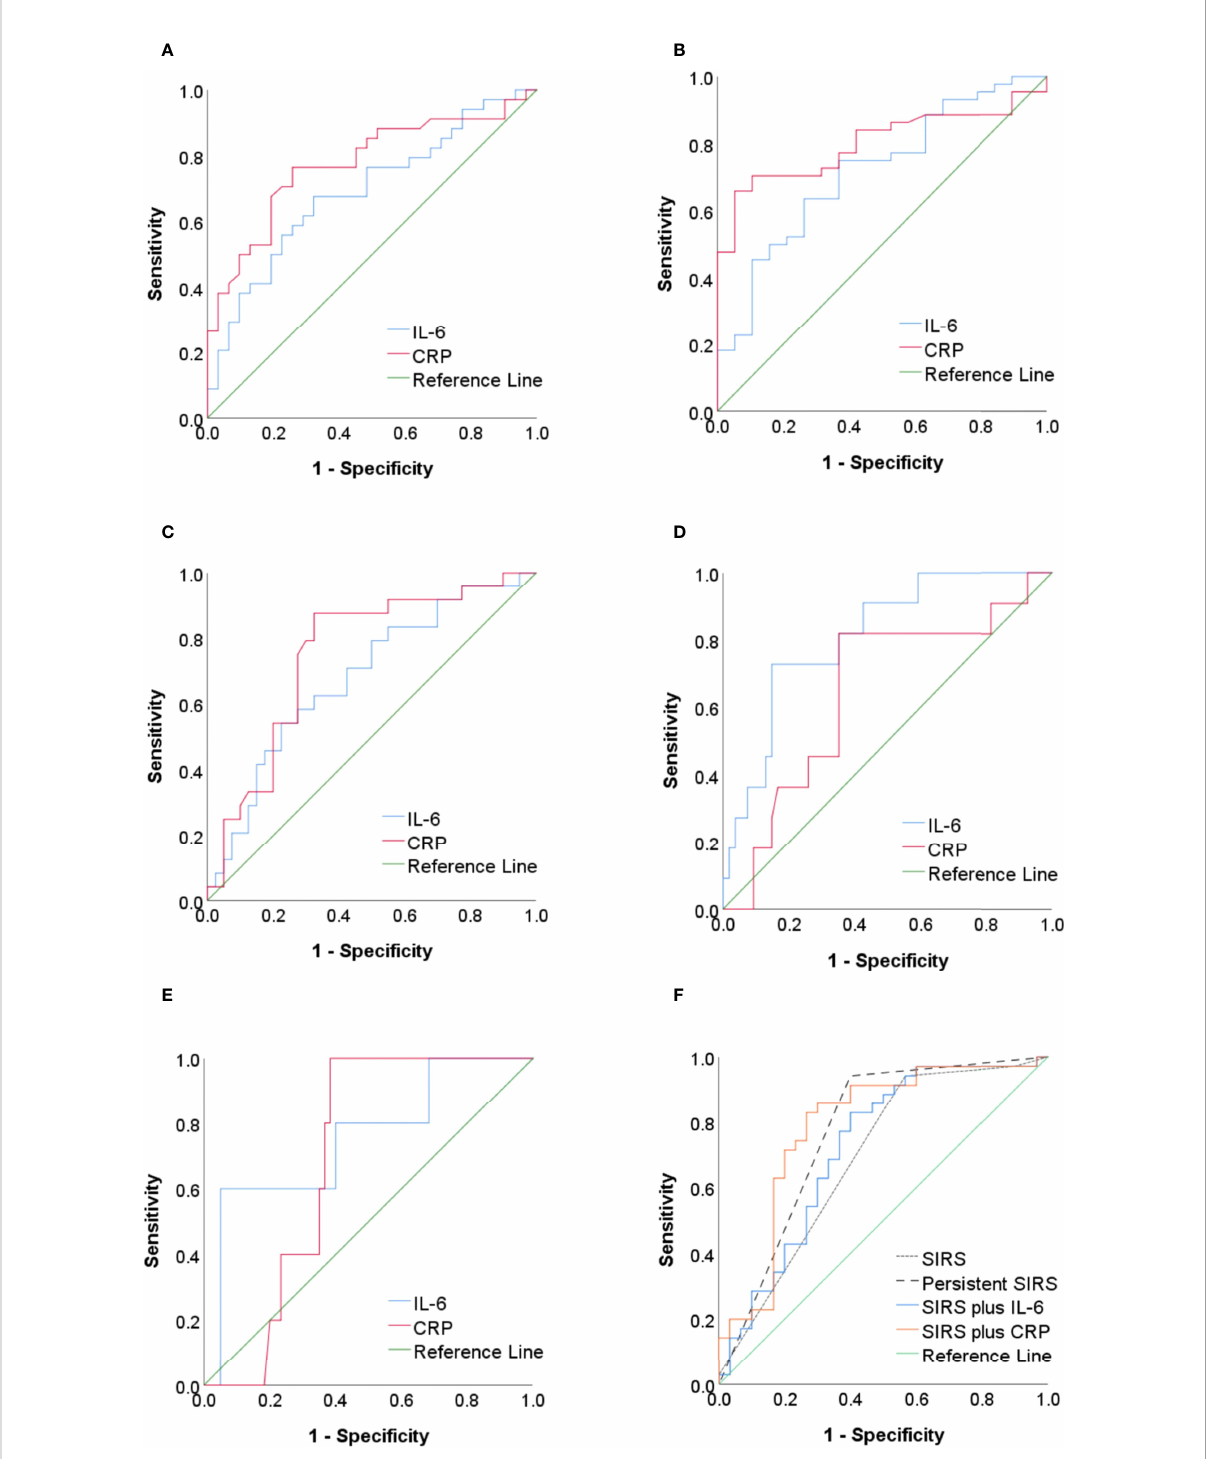
FIGURE 2 (A – E) The ROC curve of IL-6 and CRP as predictors of SAP, OF, PN, IPN, and mortality in AP. (F) The ROC curve of SIRS, persistent SIRS, IL-6 combined with SIRS, and CRP combined with SIRS as predictors of SAP. ROC, receiver operating characteristic; IL-6, interleukin-6; CRP, C- reactive protein; SAP, severe acute pancreatitis; OF, organ failure; PN, pancreatic necrosis; IPN, infected pancreatic necrosis; AP, acute pancreatitis; SIRS, systemic in fl ammatory response